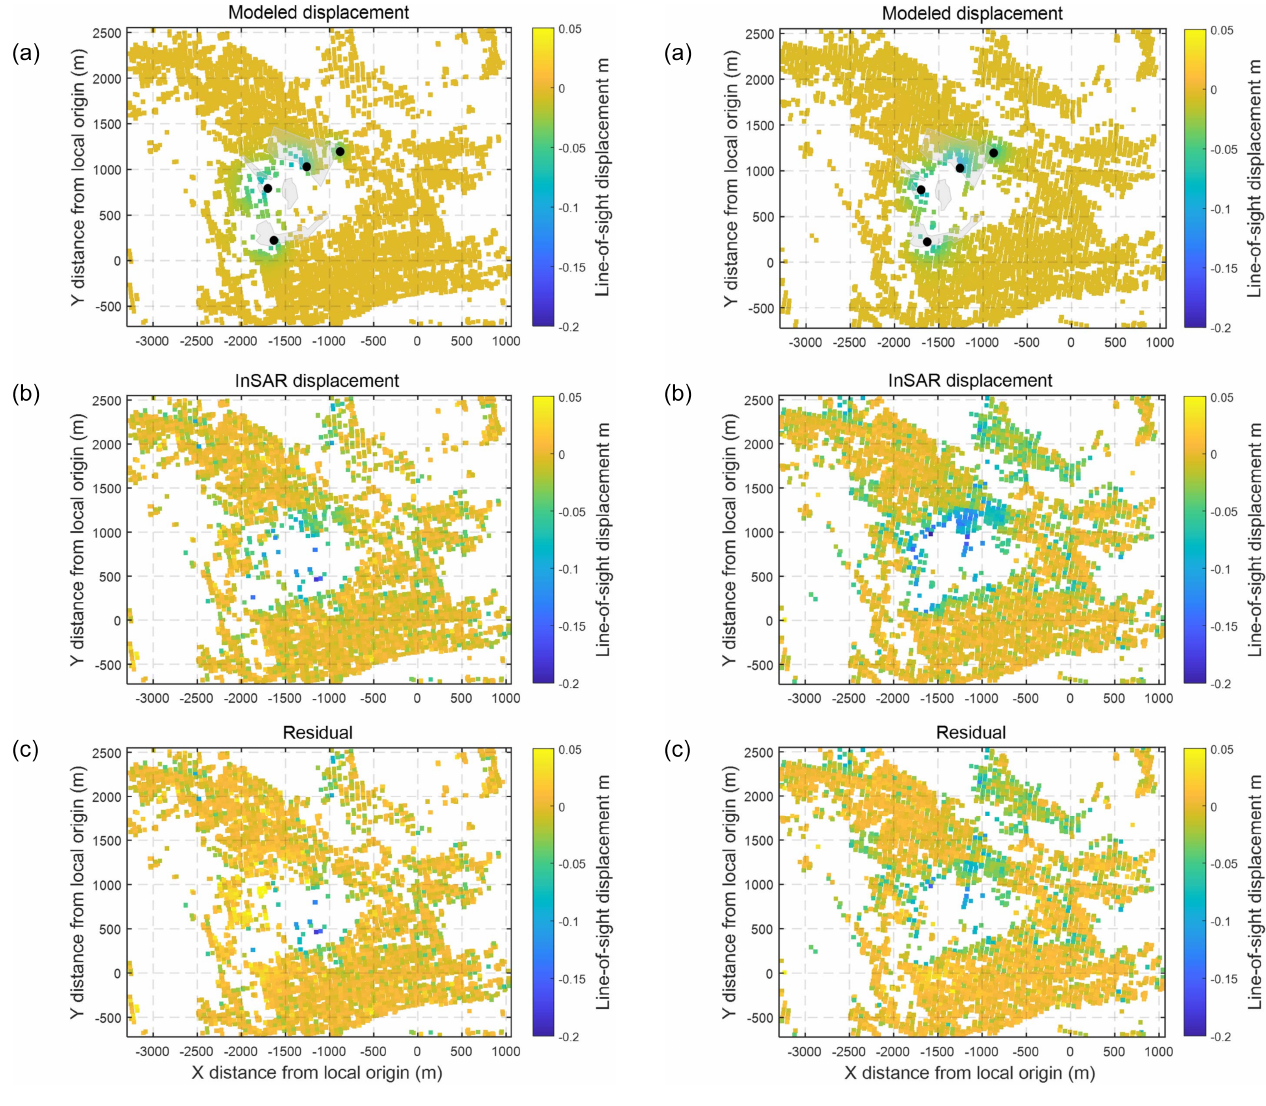
Figure 13. Cumulative LOS deformation (a) computed from the quad-configuration source model (black dots denote the location of source models; gray polygons show the boundary of mines), (b) from the ascending Sentinel-1 observation and (c) from resid- uals after subtracting the best-fitting model.